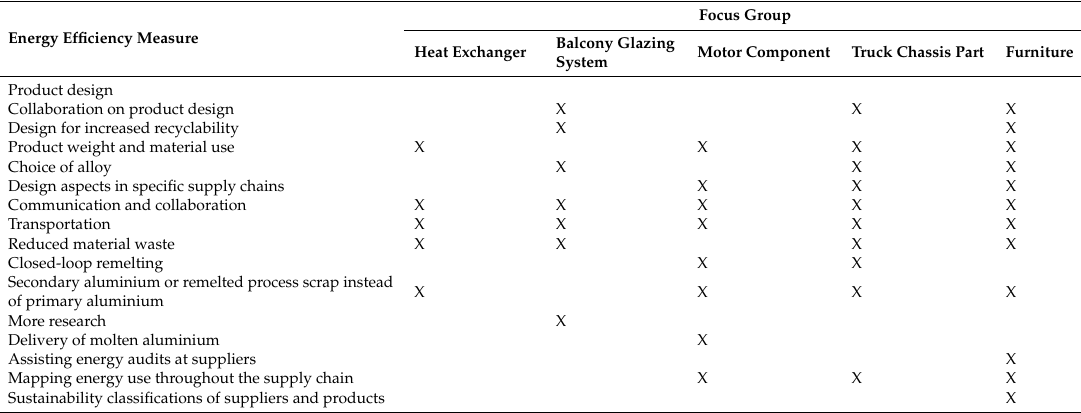
Table 3. The energy efficiency measures discussed in the different focus